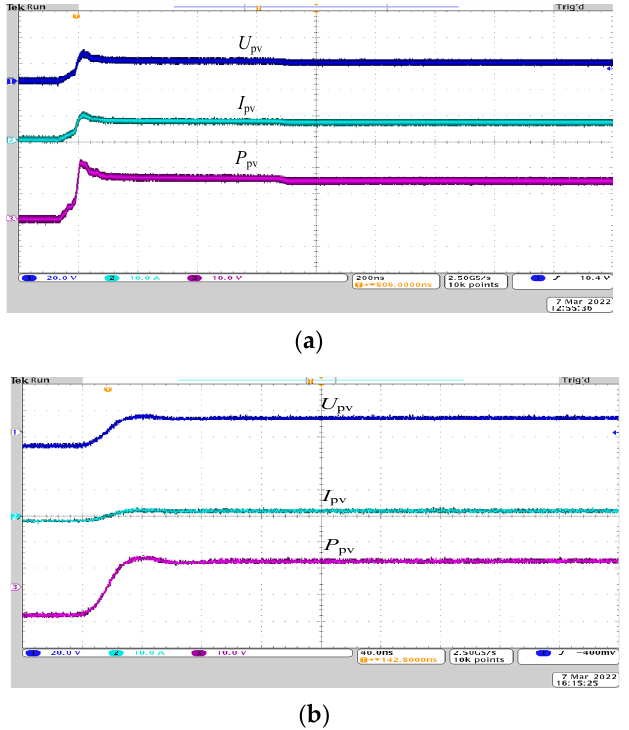
Figure 20. Experimental waveforms of the PV voltage, current and output power for different algorithms: ( a ) proposed MPPT algorithm; ( b ) exponential SMC algorithm.